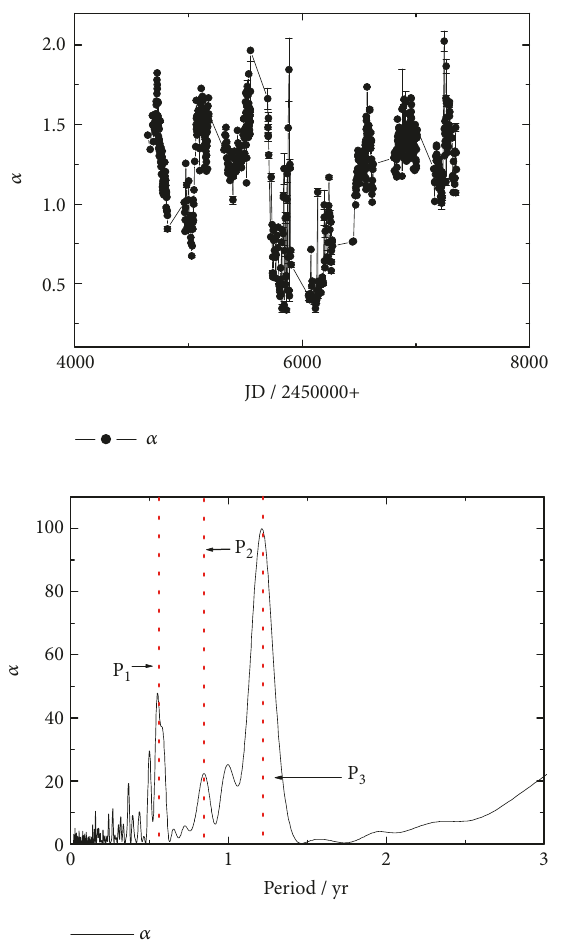
Figure 4: The 𝛼 variability and period of 3C454.3. The upper subpicture stands for 𝛼 variability and the lower subpicture stands for the quasiperiodicity, which are noted by the dot